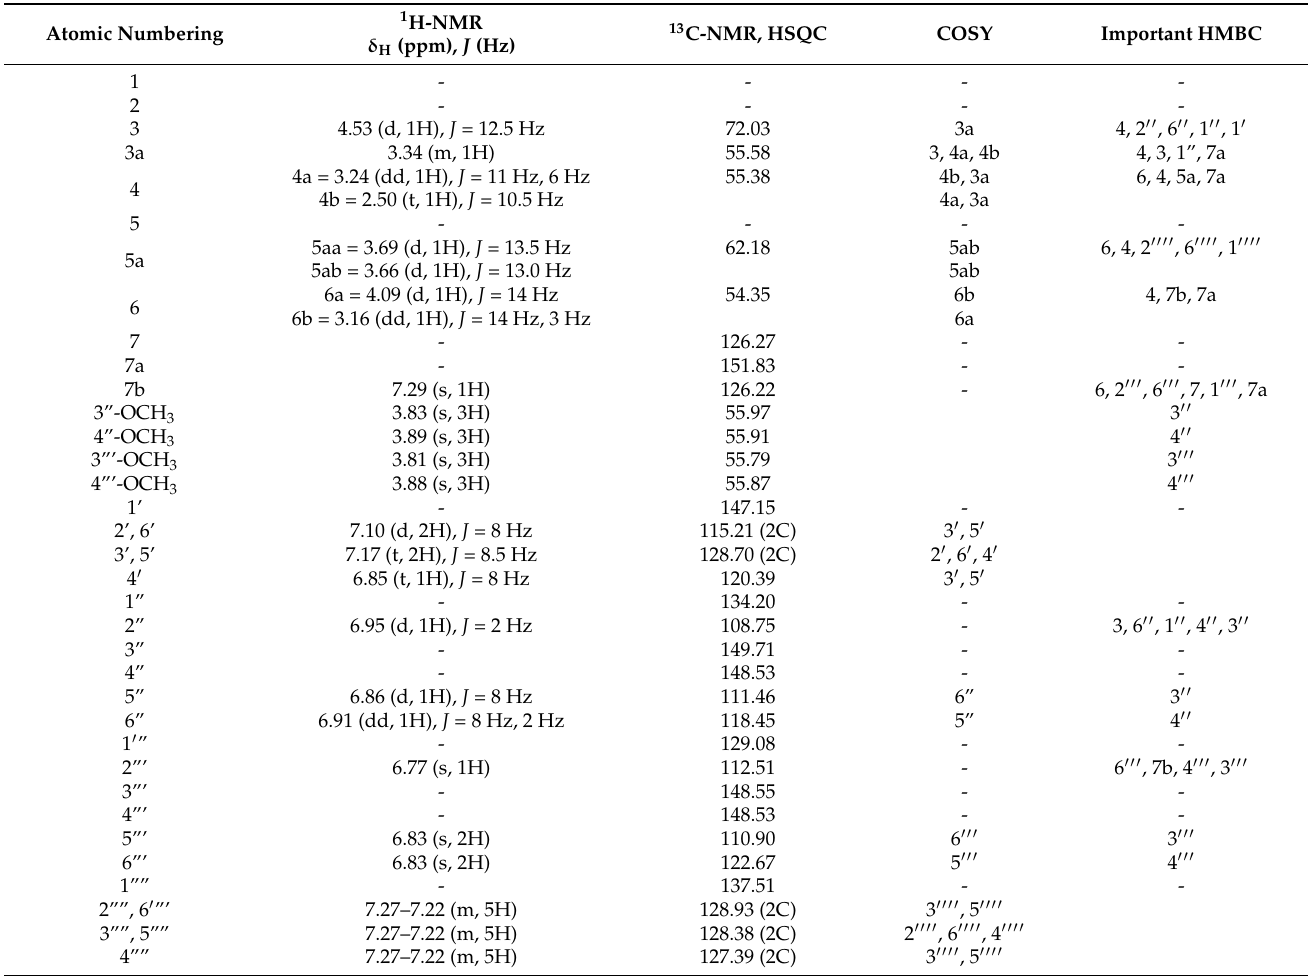
Figure 4. The 2D NMR analysis of the title compound: ( a ) the chemical shift of the carbons based on the interpretation of 13 C-NMR and HSQC spectra; ( b ) the important correlations in HMBC spectra of the title compound. Table 1. Interpretation of 1D and 2D NMR spectra of the title